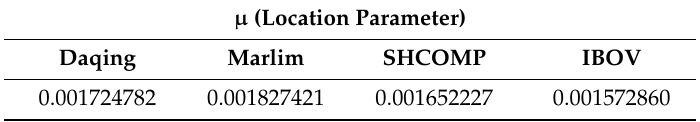
Table A14. MNIG Location parameter µ for Vector 4: Daqing, Marlim, SHCOMP,